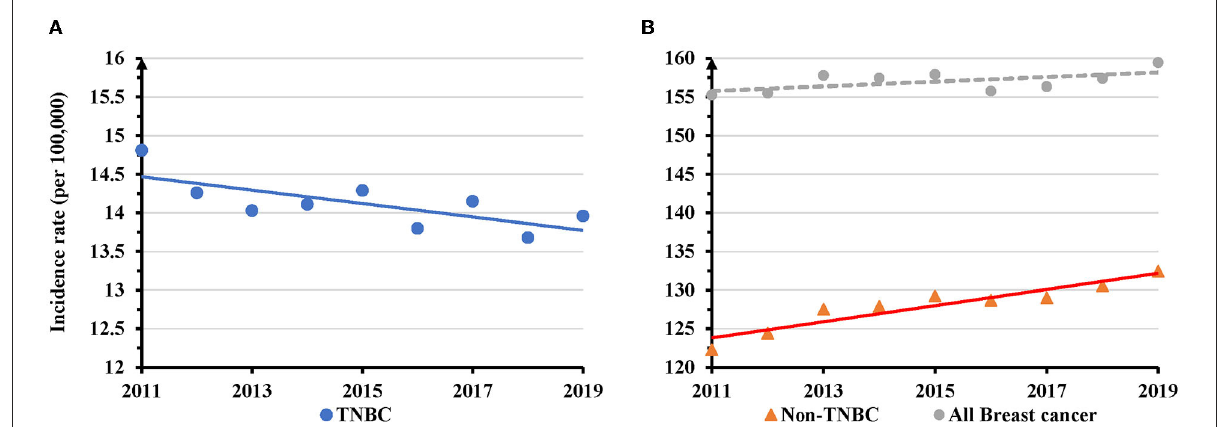
FIGURE1 Temporal changes in overall age adjusted incidence rates of TNBC, non-TNBC and all breast cancer during 2011–2019. (A) TNBC displayed a decreased trend of annual age adjusted incidence rates (AAIRs). (B) Non-TNBC, but not all breast cancer, showed an increased trend of AAIRs. Solid trend lines indicate a significant change in APC, whereas dashed lines show a non-significant change.